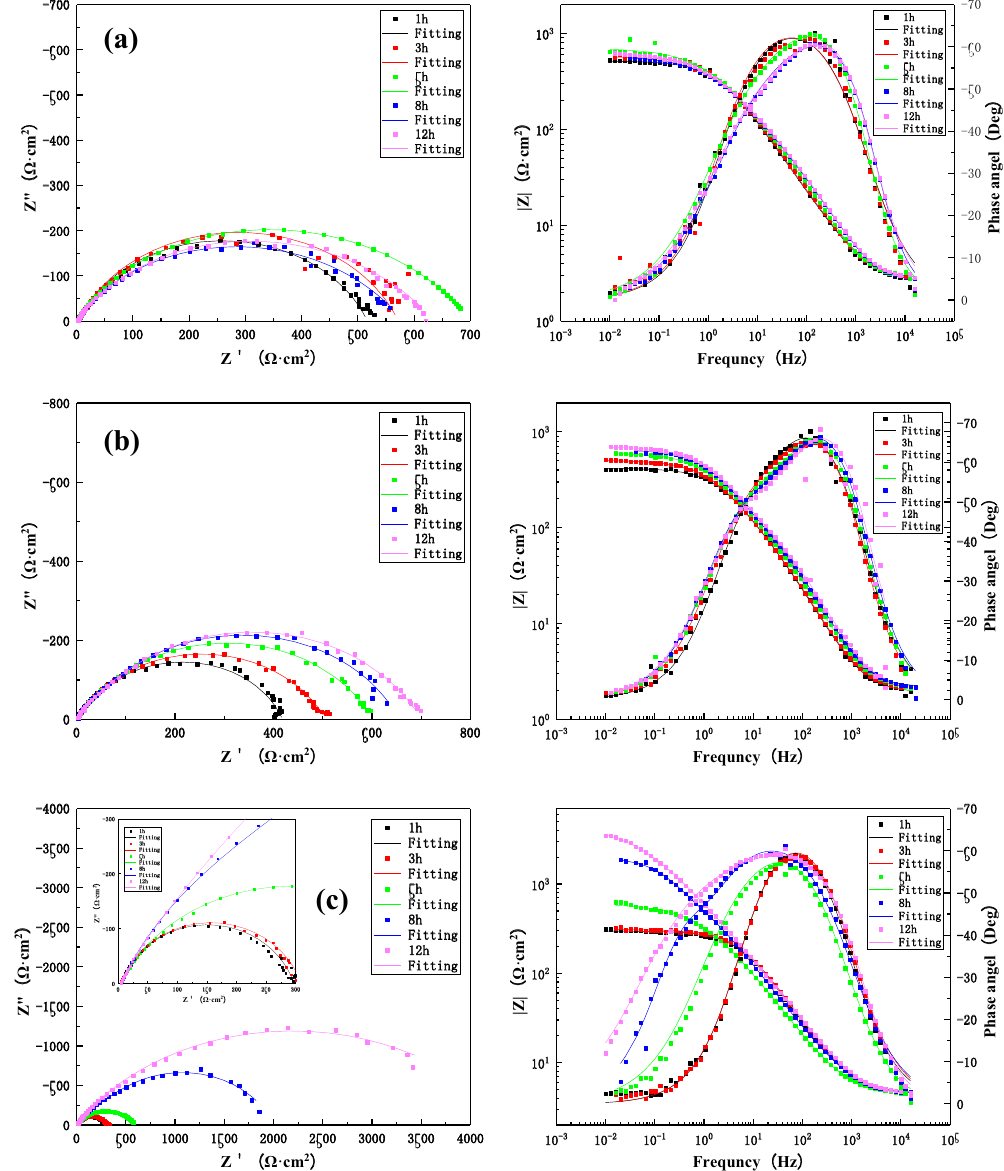
Figure 9. The impedance changes of the HAZ during 12 h scouring in seawater with different flow rates: ( a ) 1.85 m/s, ( b ) 3 m/s, ( c ) 6